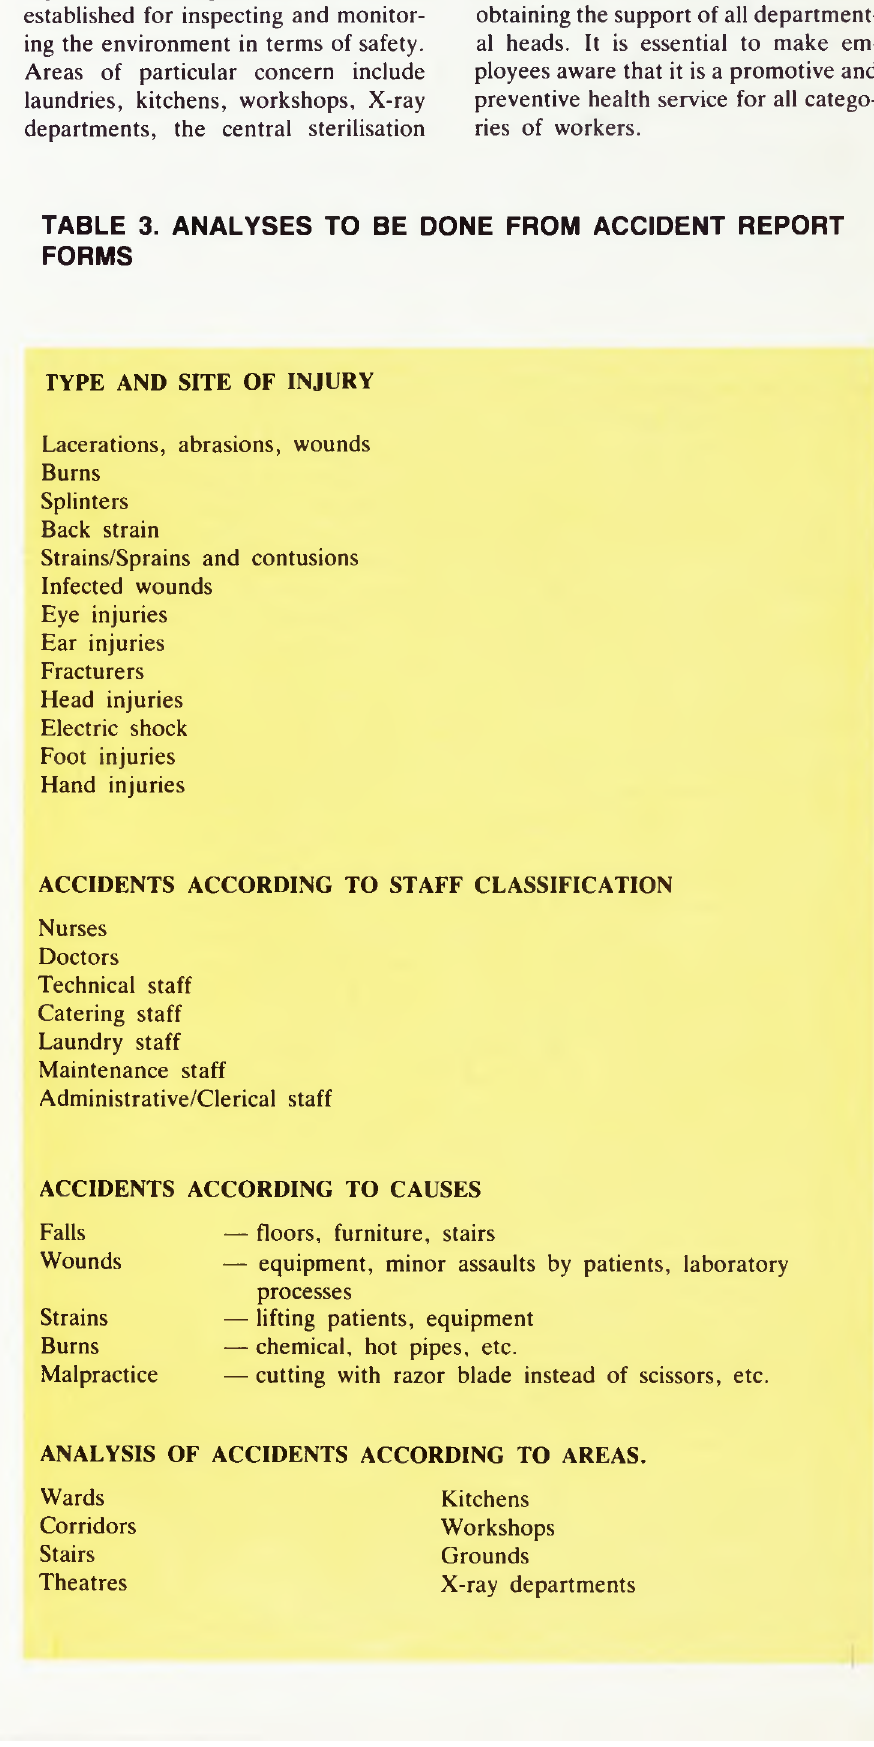
TABLE 3. ANALYSES TO BE DONE FROM ACCIDENT